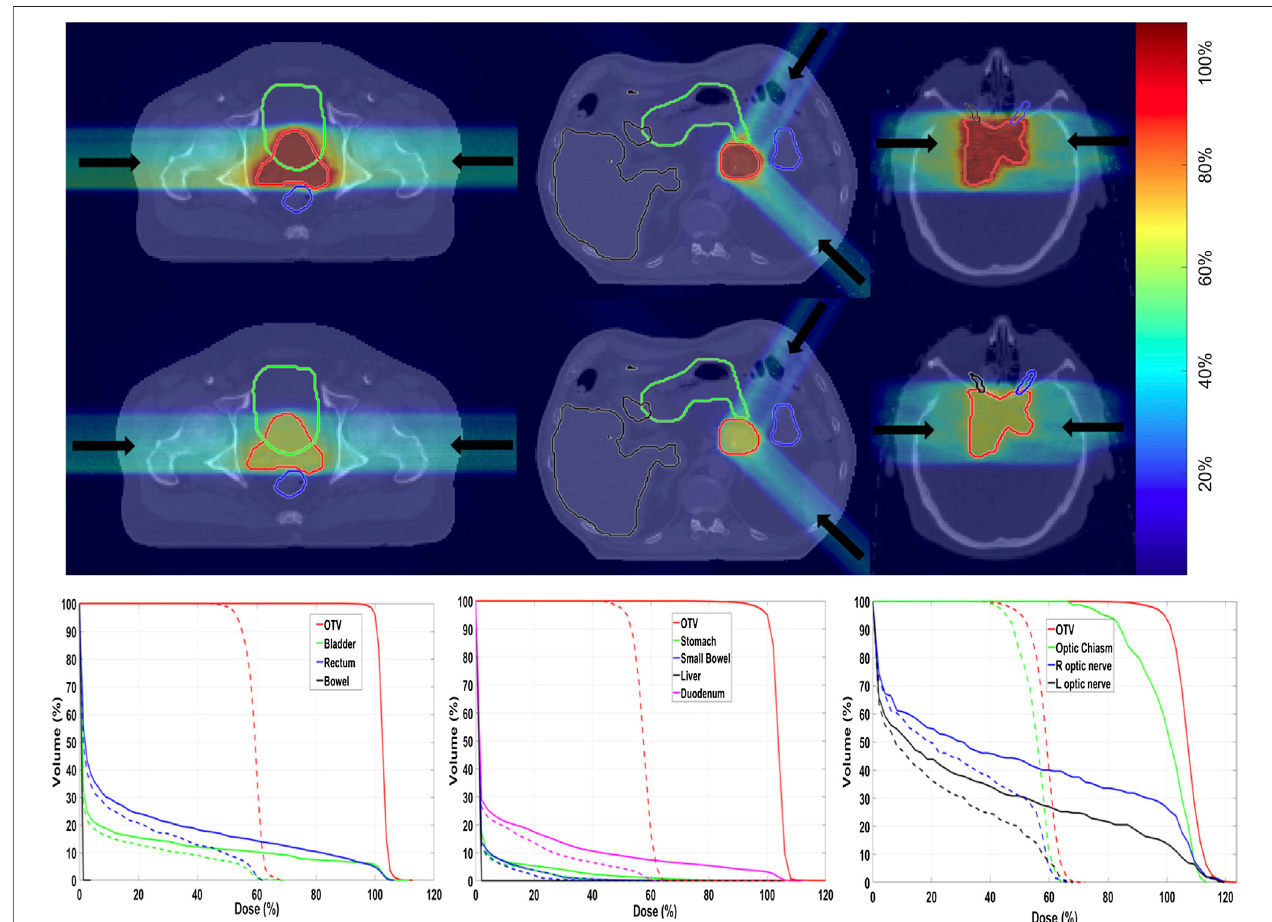
FIGURE11 | Exampleof TPScalculation with theGPU framework described in Ref.226. First and second rows arebiological dose and physical dose, overlaid on CT images, in three patient cases. From left to right: prostate, pancreatic, and brain cancers. The color bar indicates the dose levels relative to the prescription dose. Arrows indicate beam directions. The bottom row is the corresponding dose – volume histograms (DVHs). Solid lines and dashed lines denote biological dose and physical dose, respectively. The OTV represents the optimization target volume, a similar concept to CTV.